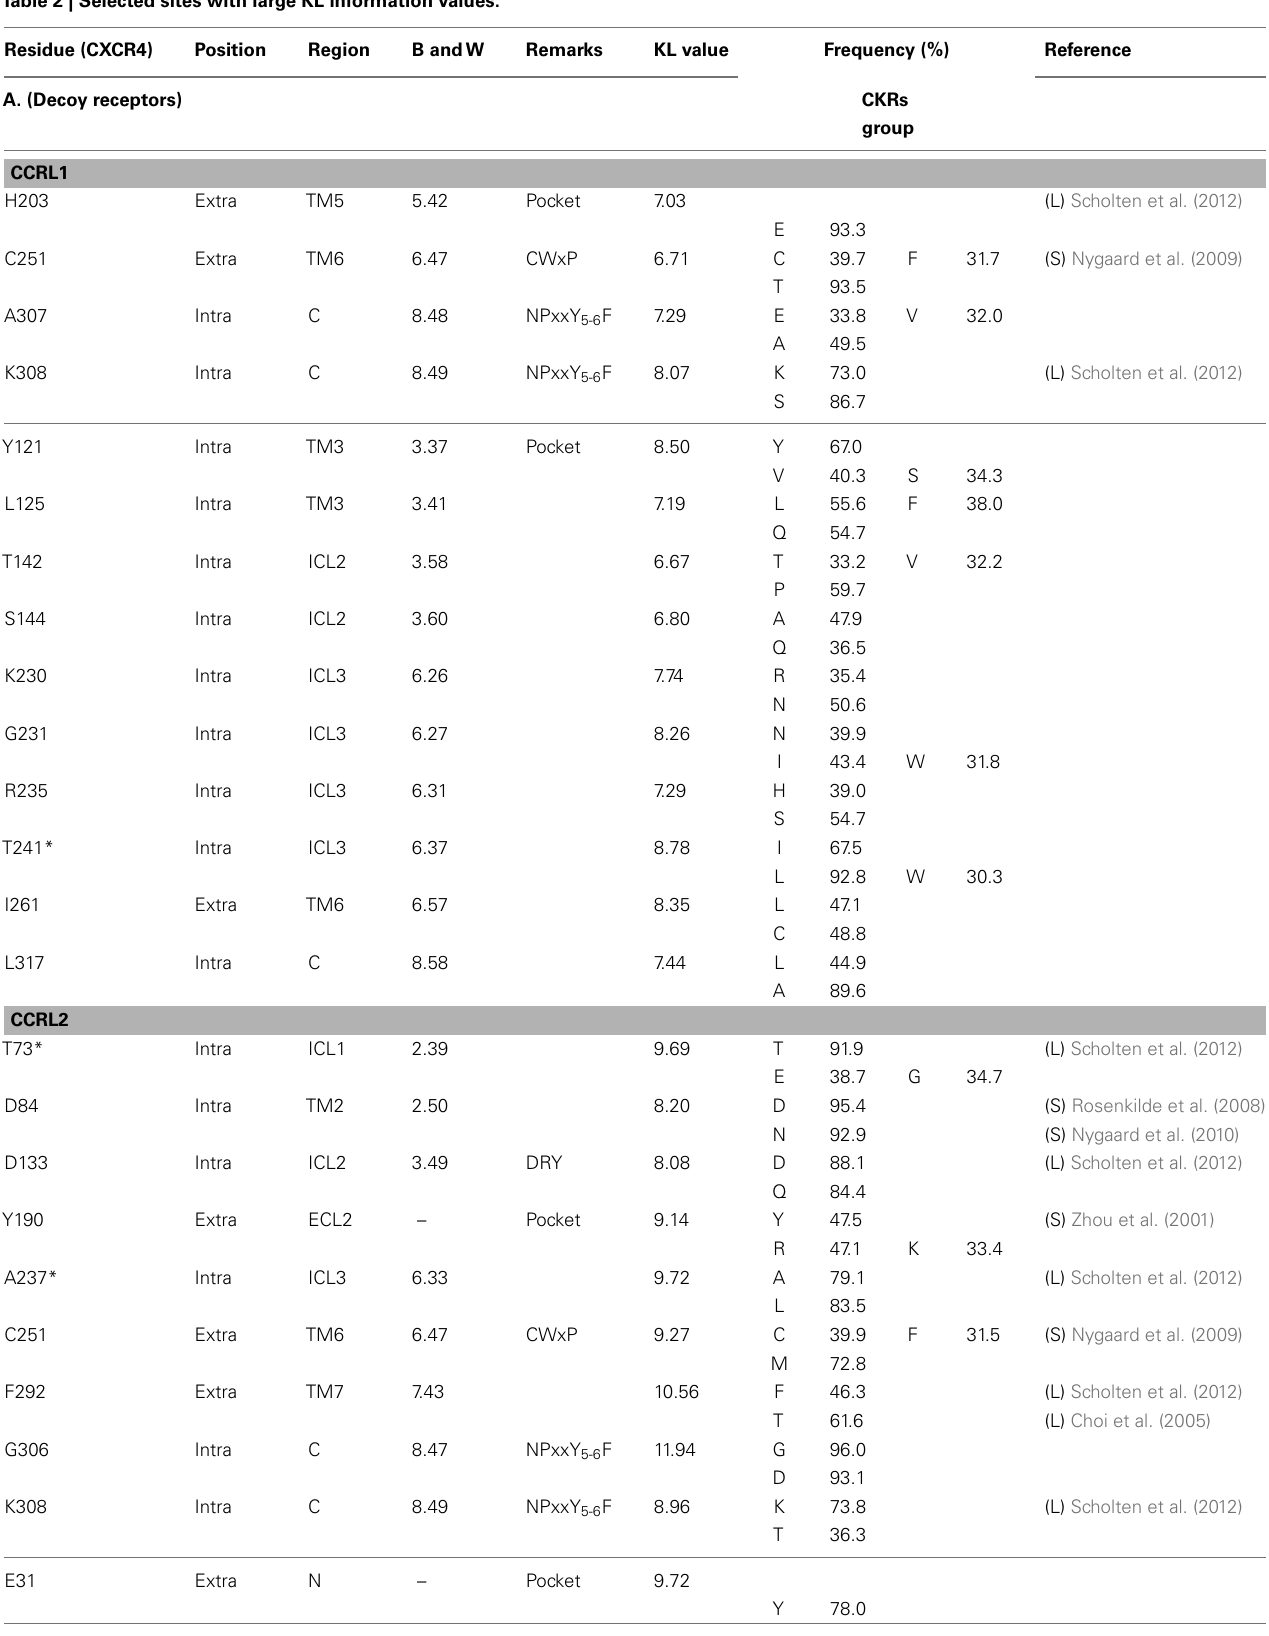
Table 2 | Selected sites with large KL information